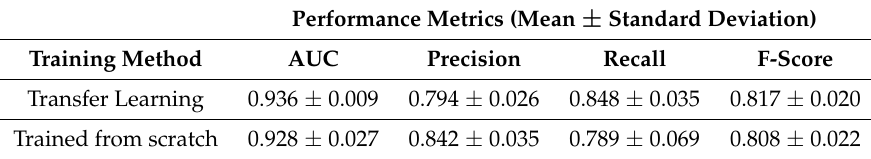
Table 4. Lung nodule malignancy classification results.